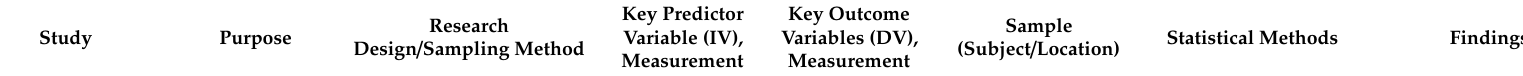
Table 1. Characteristics of the Studies on the E ff ects of Toxic Contaminations in the TSMD on the Ecological Communities and Human